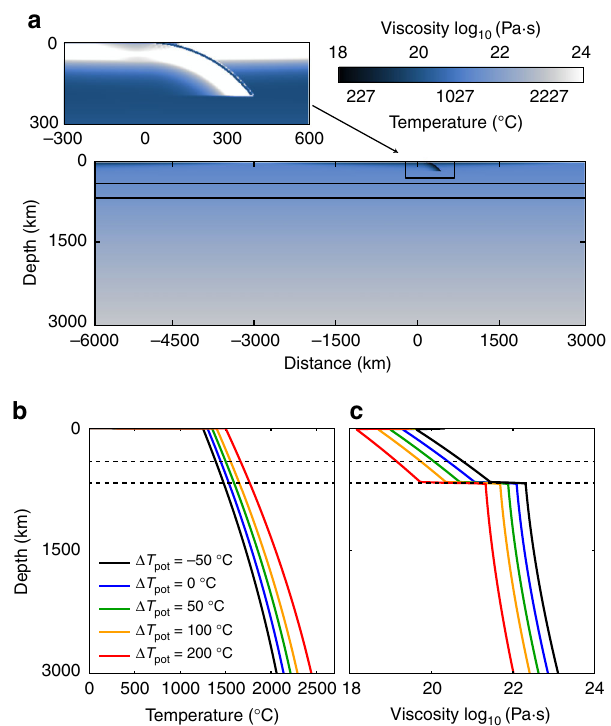
Fig. 6 Model set-up. a Initial condition for a subducting plate 100 Myr old at the reference mantle temperature ( Δ T pot = 0 °C). Colours indicate temperature and the horizontal black lines mark the olivine phase transitions. The zoomed area shows corresponding viscosity where the weak layer on top of the plate is visible (dark blue). Background mantle temperature ( b ) and viscosity ( c ) pro fi les (at the MOR) for the fi ve investigated mantle potential temperatures. The colour scale is used to identify different model cases in the main text, and ranges from black ( Δ T pot = − 50 °C) for the colder mantle temperature case to red ( Δ T pot = + 200 °C) for hottest mantle